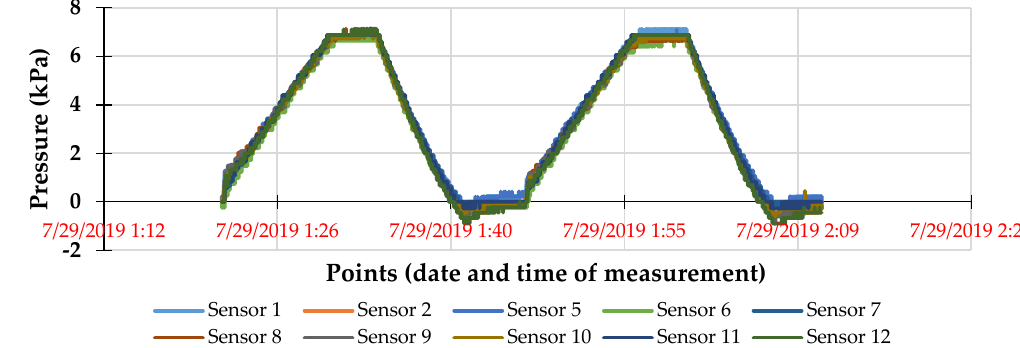
Figure A1. Calibration of the pore water pressure sensors (DMKY).